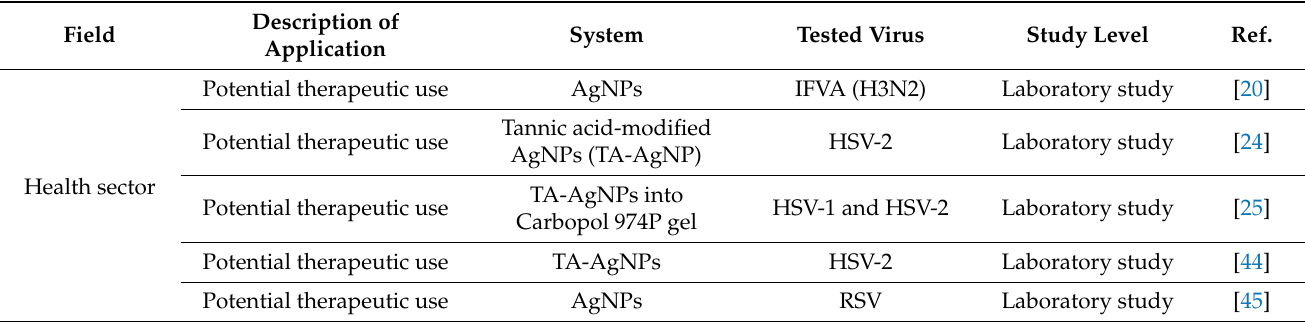
Table 3. Summary of the main applications and uses of AgNPs as antiviral agents .